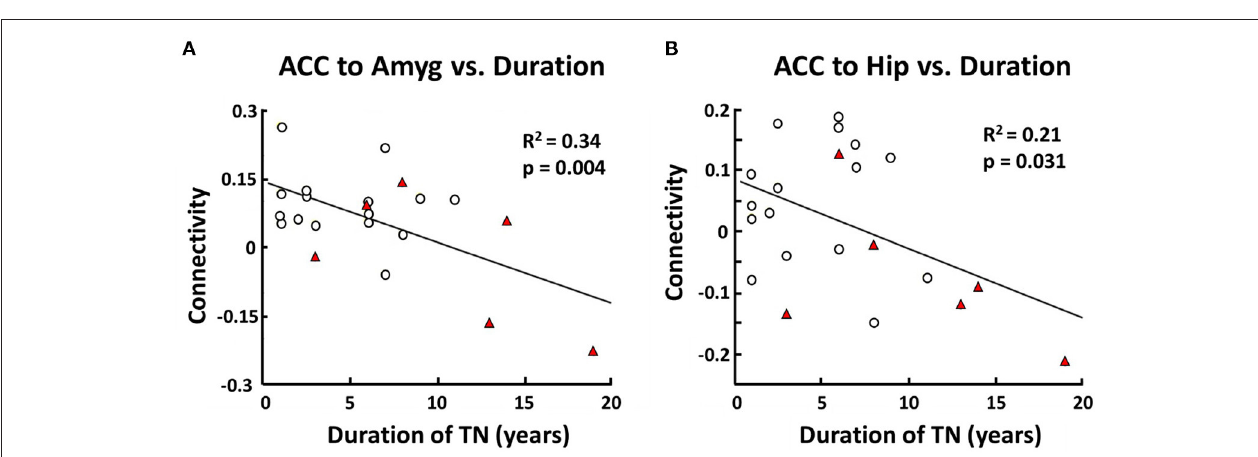
FIGURE 3 | Correlation between functional connectivity (responders vs. non-responders) and duration of TN. In TN patients there is a negative correlation between anterior cingulate cortex (ACC) and left amygdala (Amyg) resting-state functional connectivity and duration of TN in years ( R 2 = 0.34, p = 0.004) (A) . There is also a negative correlation between ACC and right hippocampus (Hip) resting-state functional connectivity and duration of TN in years ( R 2 = 0.21, p = 0.031) (B) . Pearson Correlation was used with a threshold for statistical significance set at p < 0.05.